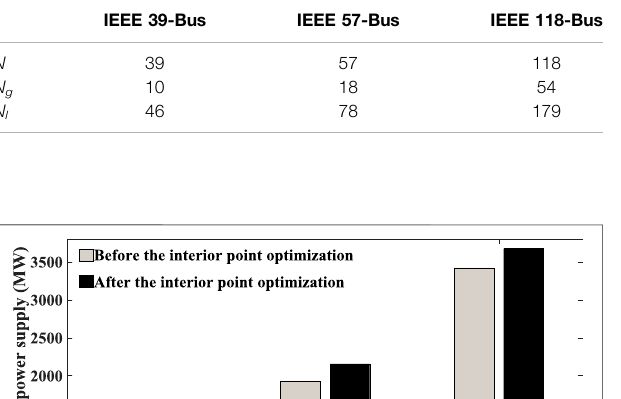
TABLE 1 | Number of buses N , generators N g , and transmission links N l of the three tested power networks. IEEE 39-Bus